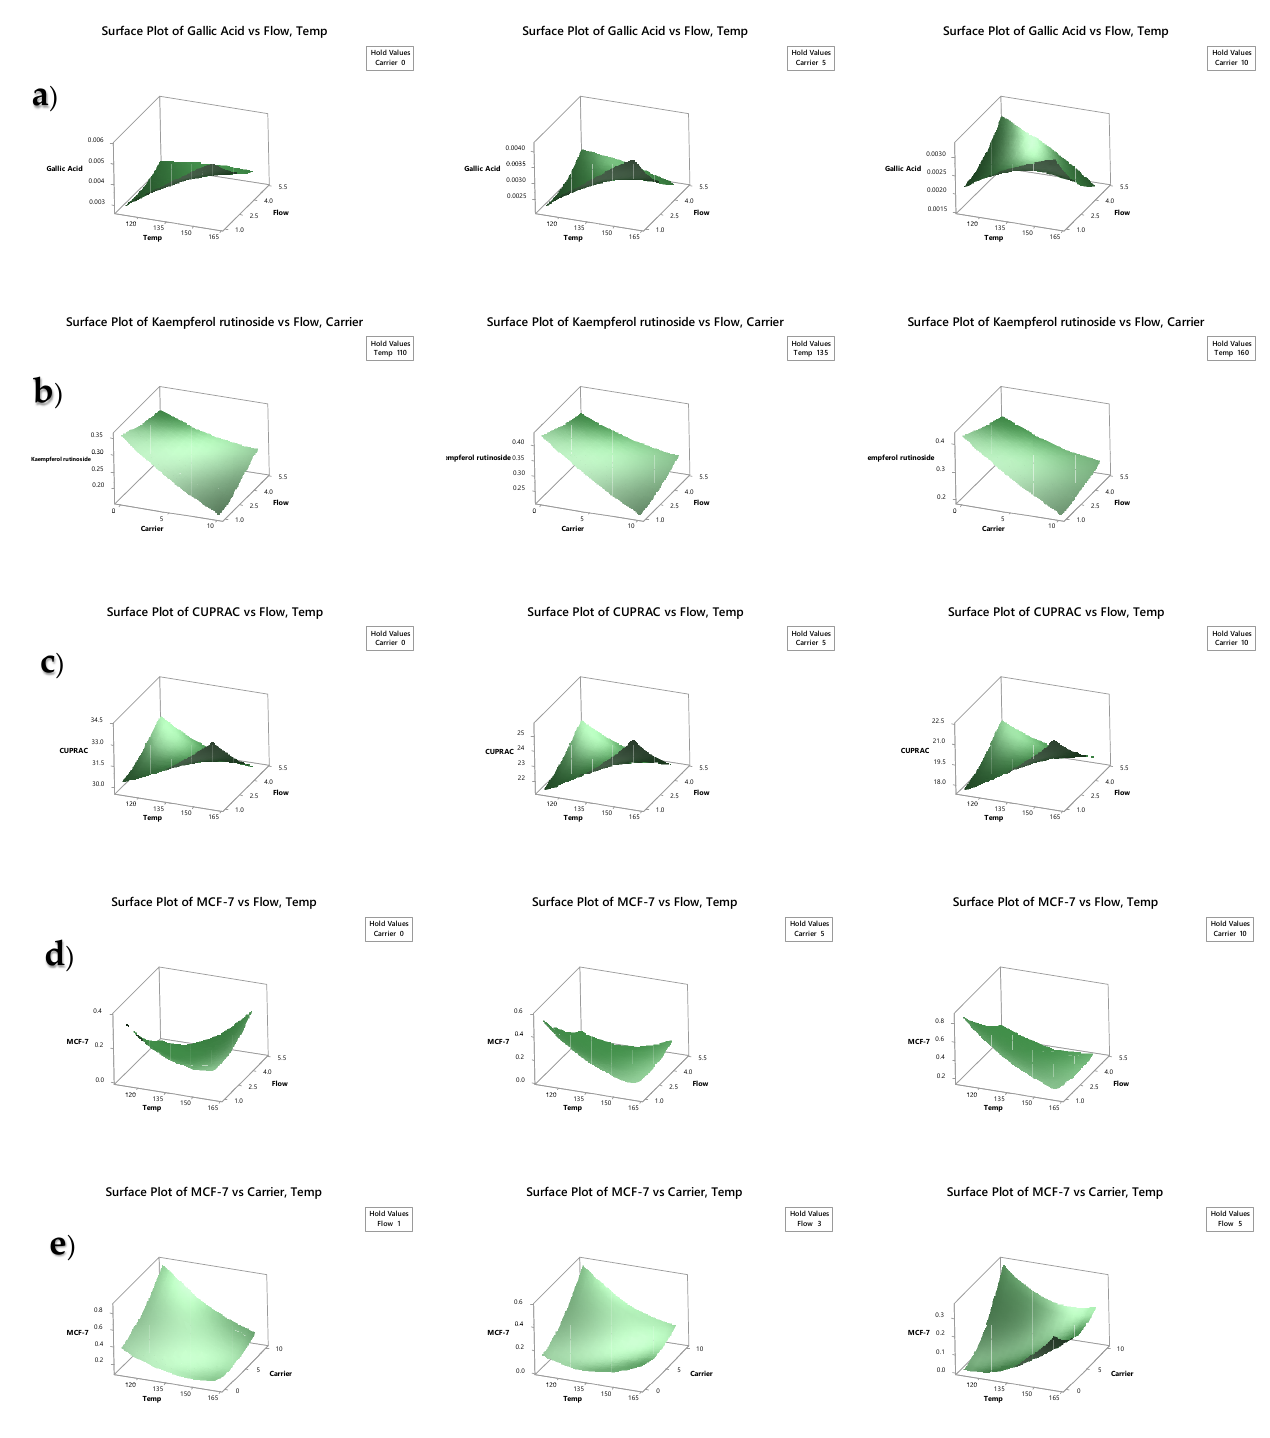
Figure 2. Response surface three-dimensional plots of significant interactions for gallic acid ( a ), kaempferol rutinoside ( b ), antioxidant capacity measured by the CUPRAC method ( c ), and IC50 values for MCF-7 cancer cell line ( d , e ) as a function of the studied factors.